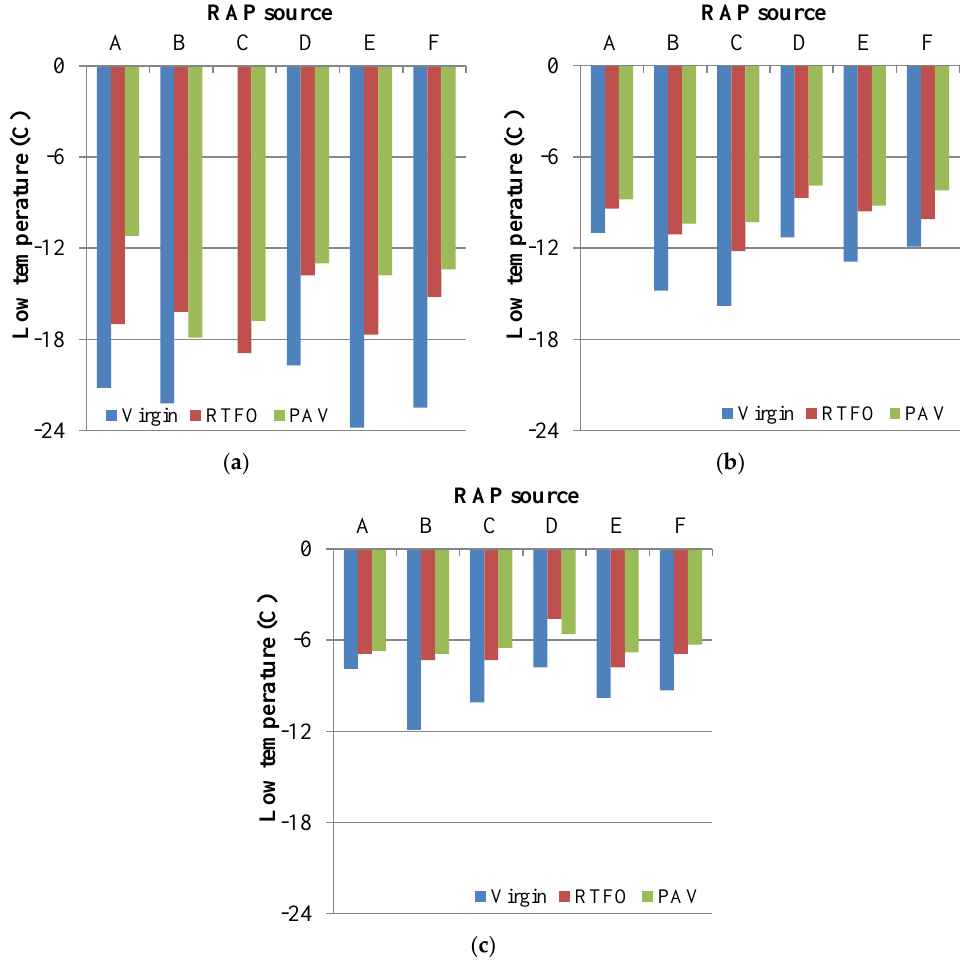
Figure 10. Minimum low temperatures of RAP mortars in terms of aged binder percentage and binder aged states, ( a ) 5% aged binder; ( b ) 10% aged binder; ( c ) 15% aged binder.